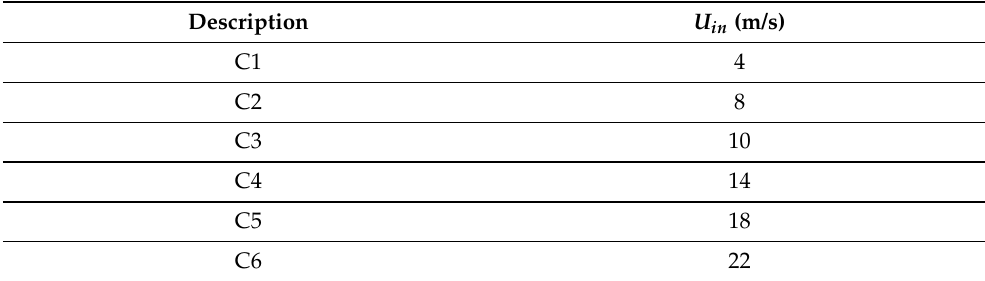
Table 1. Summary of the simulated cases in this